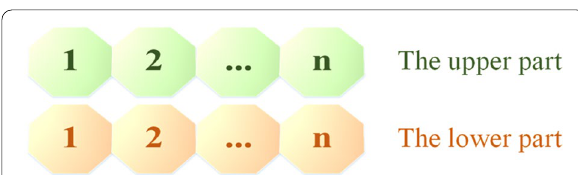
Fig. 10 The gene of and individual or the position of a search agent to optimize the ANN’s